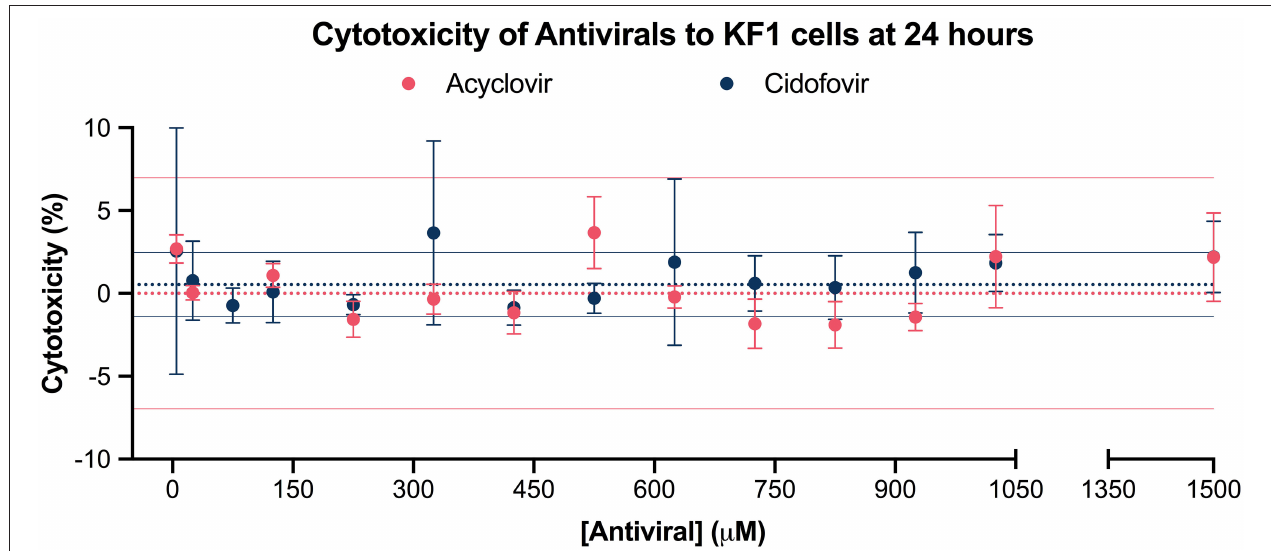
FIGURE 1 | Cytotoxicity of acyclovir and cidofovir to KF1 cells at 24h. Antiviral cytotoxicity on the koi fin cell line (KF1) was evaluated by exposing the cells to concentrations from 5 µ M to 1,500 µ M for 24h and measuring the release of lactate dehydrogenase in antiviral-treated cells, negative controls, and positive controls. The solid dots represent the mean cytotoxicity percentage at each exposed concentration, with standard error of the mean plotted. The dotted line represents the mean cytotoxicity percentage of the negative control, while the solid lines represent its 95% confidence interval. The different experimental groups are color coded. Results suggest that both acyclovir and cidofovir at the tested concentrations are non-cytotoxic to KF1 cells when compared to the negative control.